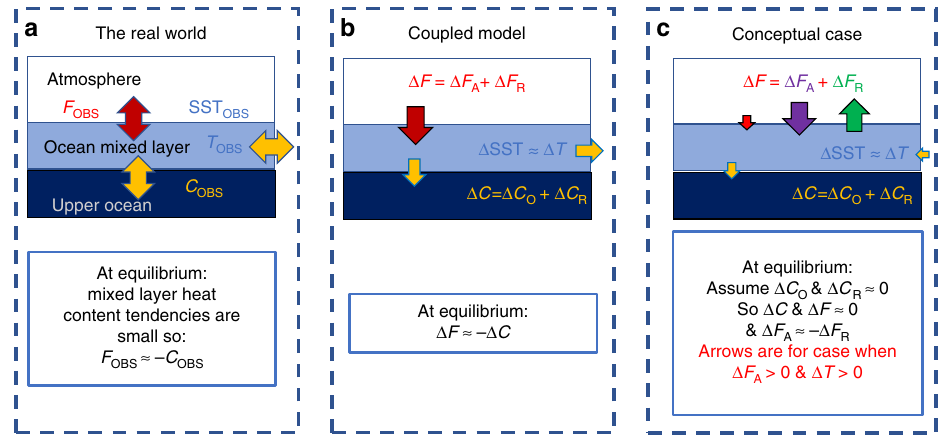
Fig. 2 Schematic diagrams of the mixed layer heat budget. a the real world, b any coupled model, c a simpli fi ed coupled model conceptual case, where we assume a small stand-alone ocean model combined horizontal and vertical heat transport convergence bias ( Δ C O ) and a small coupled ocean heat transport convergence response ( Δ C R ). F OBS is the observed surface heat fl ux, C OBS is the observed combined vertical and horizontal ocean heat transport convergence and T OBS is the mixed layer temperature or SST. The simulated mixed layer temperature bias, Δ T , is assumed to be equal to the SST bias. The simulated surface heat fl ux bias, Δ F , can be decomposed into a stand-alone atmospheric model bias ( Δ F A ) and a coupled response ( Δ F R ). The simulated combined vertical and horizontal ocean heat transport convergence bias, Δ C , can be decomposed into a stand-alone ocean model bias ( Δ C O ) and a coupled response ( Δ C R ). In ( c ) the simpli fi ed conceptual case since Δ C O and Δ C R are assumed small, Δ C & Δ F must both also be small. Hence, Δ F A must be approximately compensated for by Δ F